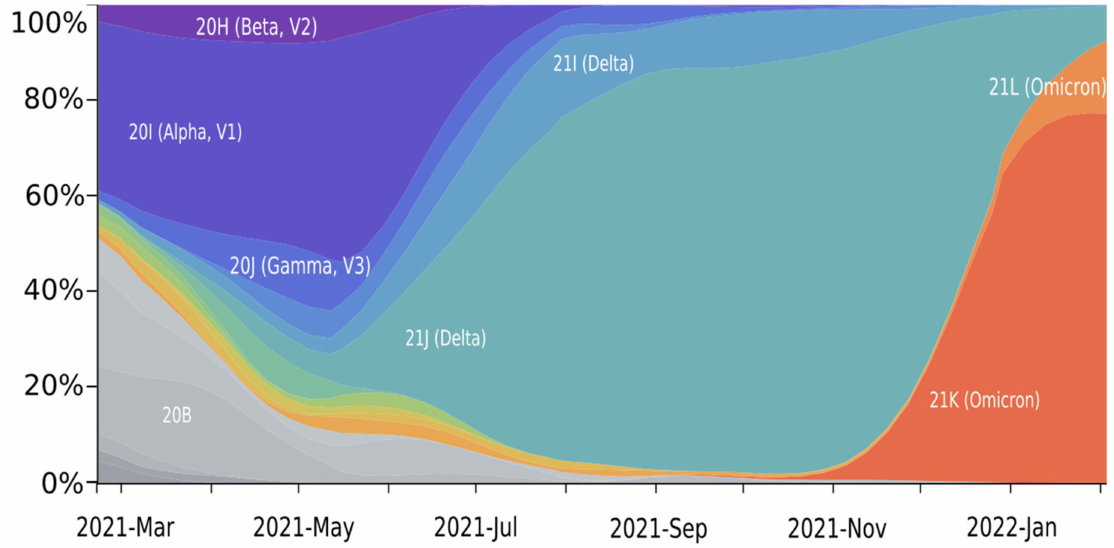
Figure 2. SARS-CoV-2 clade distribution dynamics. Colors are allocated according to Nexstrain Clades: 20B—grey; 20H—purple; 20I—dark blue; 20J—blue; 21A—light blue; 21I—lilac blue; 21J—blue-green; 21L—orange; 21K—orange red. Generated by NextStrain